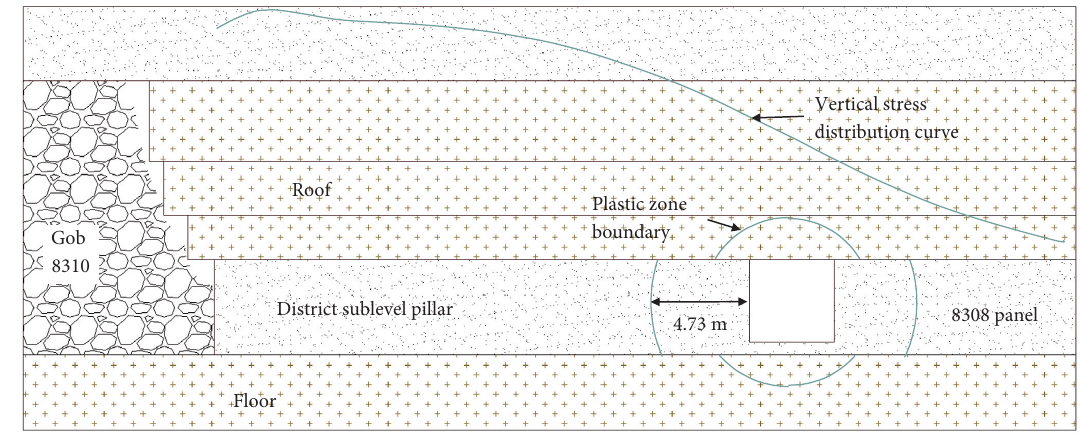
Figure. 9: Coal and rock structure and plastic zone boundary of the gob-side roadway. Table 1: Mechanical parameters of coal and rock layer.